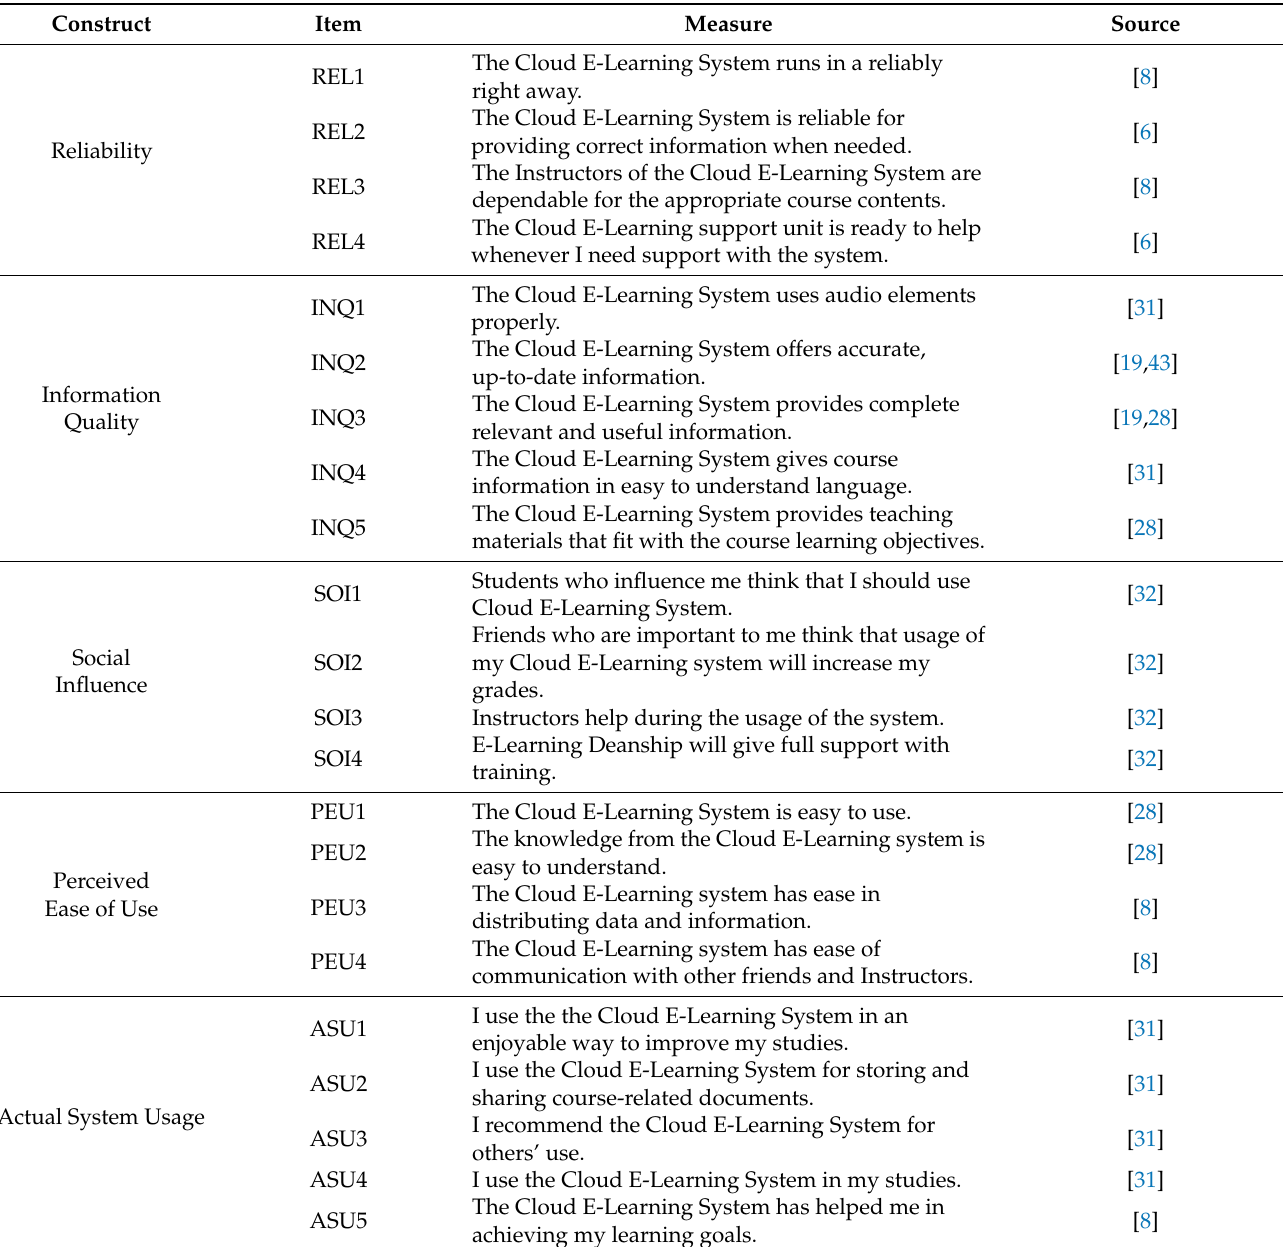
Table A1. Construct Measurements and